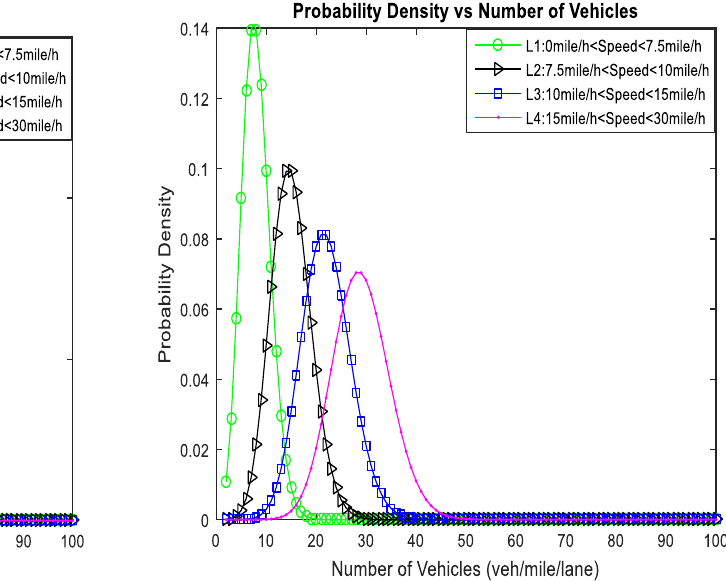
Figure 9. The effect of traffic flow when λ =7 Figure 10. The effect of traffic flow when λ